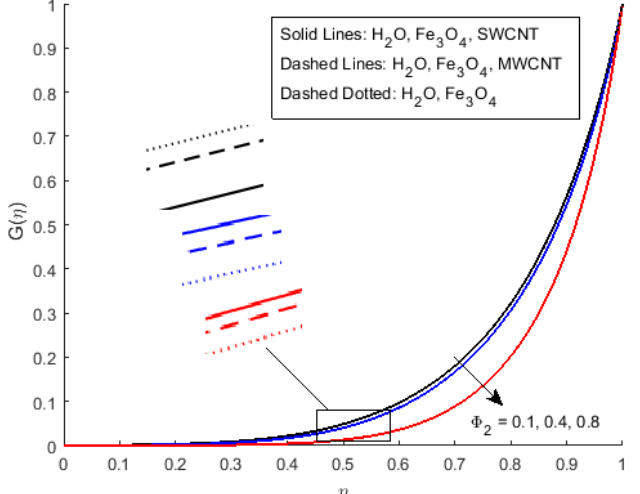
Figure 6. Effect of G ( η ) for Φ 2 and fixed values of S = 1.5, Re m = 1.5, Ha = 0.4, Pr = 6.2, Ec = 0.5, δ = 0.4, Φ 1 = 0.02, m = 0.3.